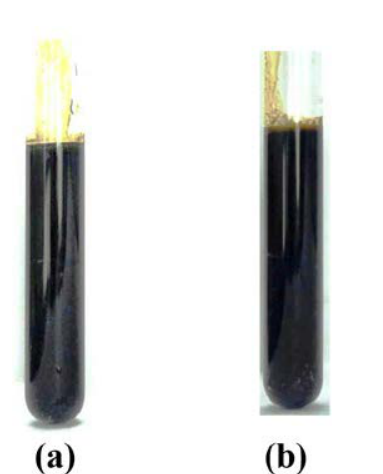
Fig. 5. AgNPs (a) fresh (b) after 5